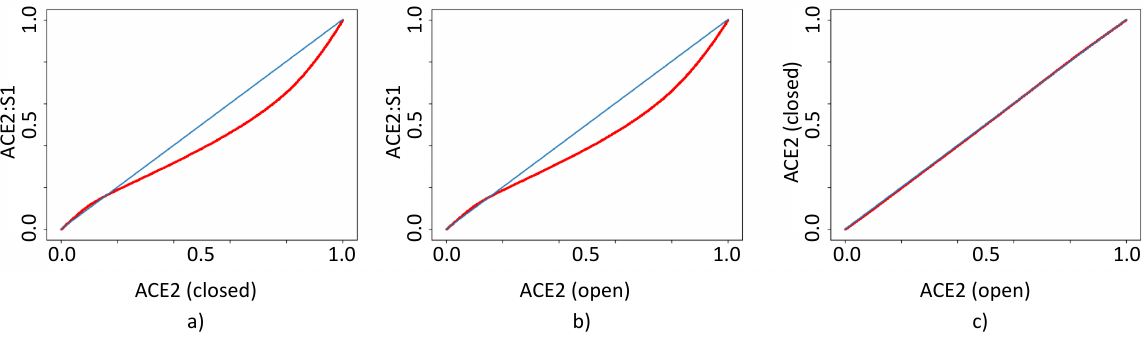
Figure 8. Correlation diagram for SSnet scores between each of the protein targets for ligands in BDB ( a ) ACE2:S1 vs. ACE2(closed), ( b ) ACE2:S1 vs. ACE2(open), and ( c ) ACE2 (open) vs. ACE2 (closed). The red curve shows the scores for ligands plotted as x, y. The blue curve is an x = y line representing non-selectivity to the ACE2 conformation. The highest difference between scores is achieved for probabilities in the range 0.60–0.70. High probability binders show no